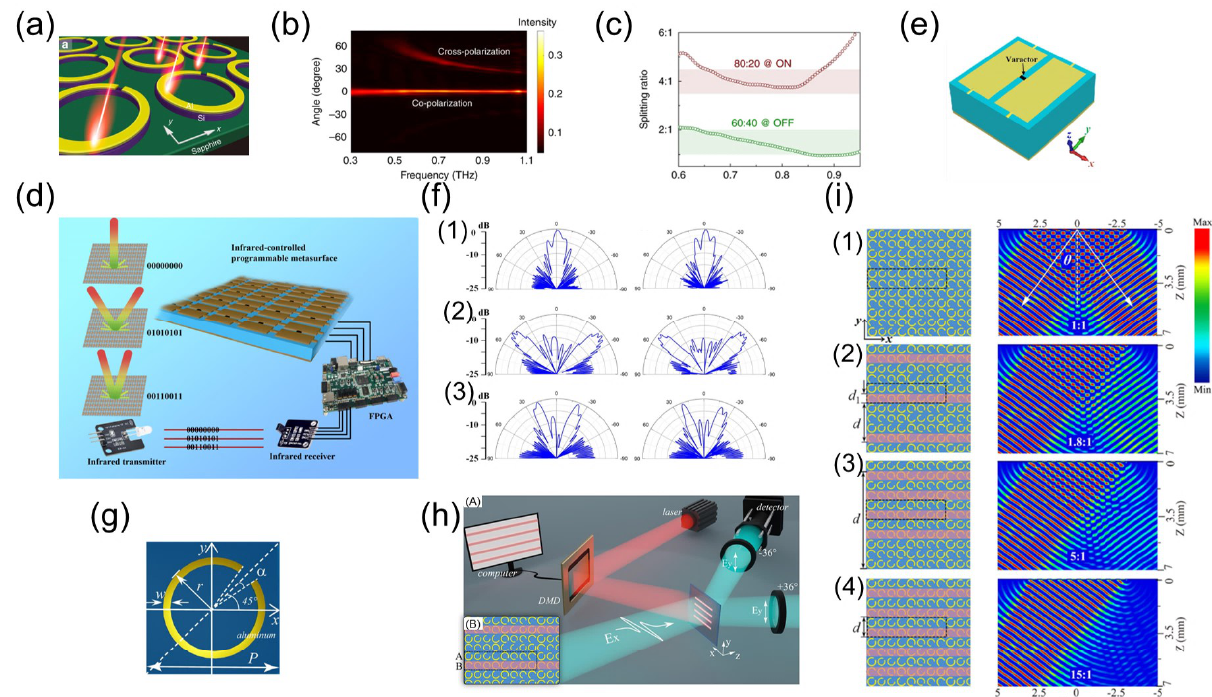
Figure 20. ( a ) Schematic diagram of the hybrid circular split-ring resonator [148]. ( b ) Transmission intensities of co-polarized and cross-polarized components split in the broadband range [148]. ( c ) Synthetic active modulation of the broadband splitting ratio between co–polarized (normal) and cross-polarized (deflected) components [148]. ( d ) Schematic illustration of the proposed infrared- controlled programmable metasurface. Reprinted from [149], Copyright 2020, with permission from Elsevier. ( e ) The structure of the digitally encoded unit cell. Reprinted from [149], Copyright 2020, with permission from Elsevier. ( f ) ( 1 – 3 ) Reflected beams under three different coding sequences at 4.10 GHz (left) and 4.35 GHz (right). Reprinted from [149], Copyright 2020, with permission from Elsevier. ( g ) Top view of the unit cell of the C-shaped metallic SRR structure [150]. ( h ) Schematic diagram of the beam splitter combined with the light control scheme [150]. ( i ) ( 1 – 4 ) Partial sketch of the designed metasurface illuminated with a red stripe pattern on the left, the dashed box represents the basic unit cell, and on the right is the electric field distribution of the simulated beam splitting in the corresponding illumination pattern at 0.8 THz